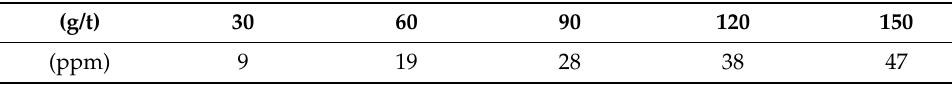
Table 3. MIBC dosages and concentrations in the pulp.